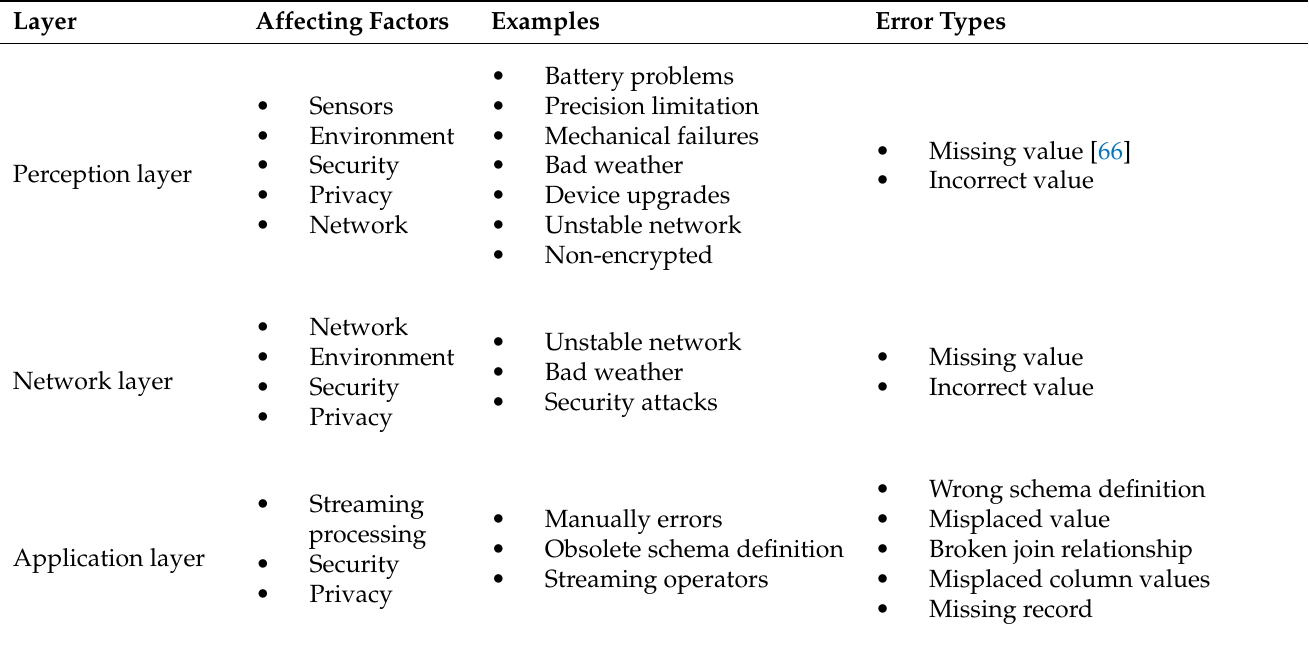
Table 2. Layered distribution of factors threatening IoT